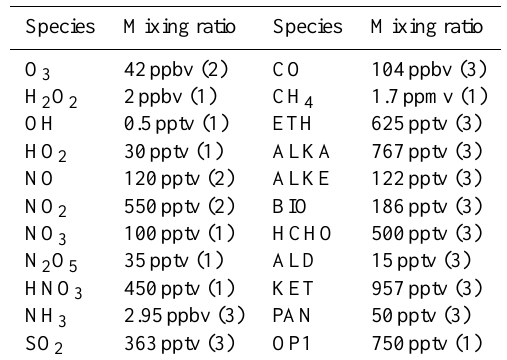
Table 6. Initial gas mixing ratios in the COPT case. The form of the vertical profile is indicated in parentheses as 1 for homogeneous, 2 for stratospheric, and 3 for boundary layer